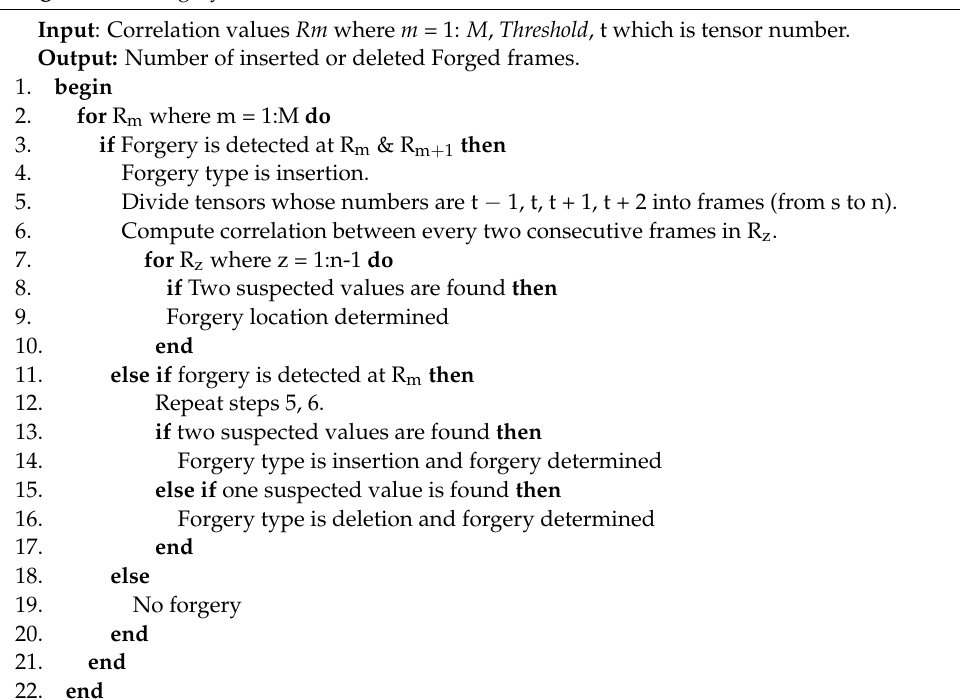
Figure 5. Inter-frame of foreman video sequence Correlation distribution: ( a ) Original video and ( b ) Forged video (Insertion attack) ( c ) Forged video (Deletion attack). Algorithm 2 Forgery Location Determination.